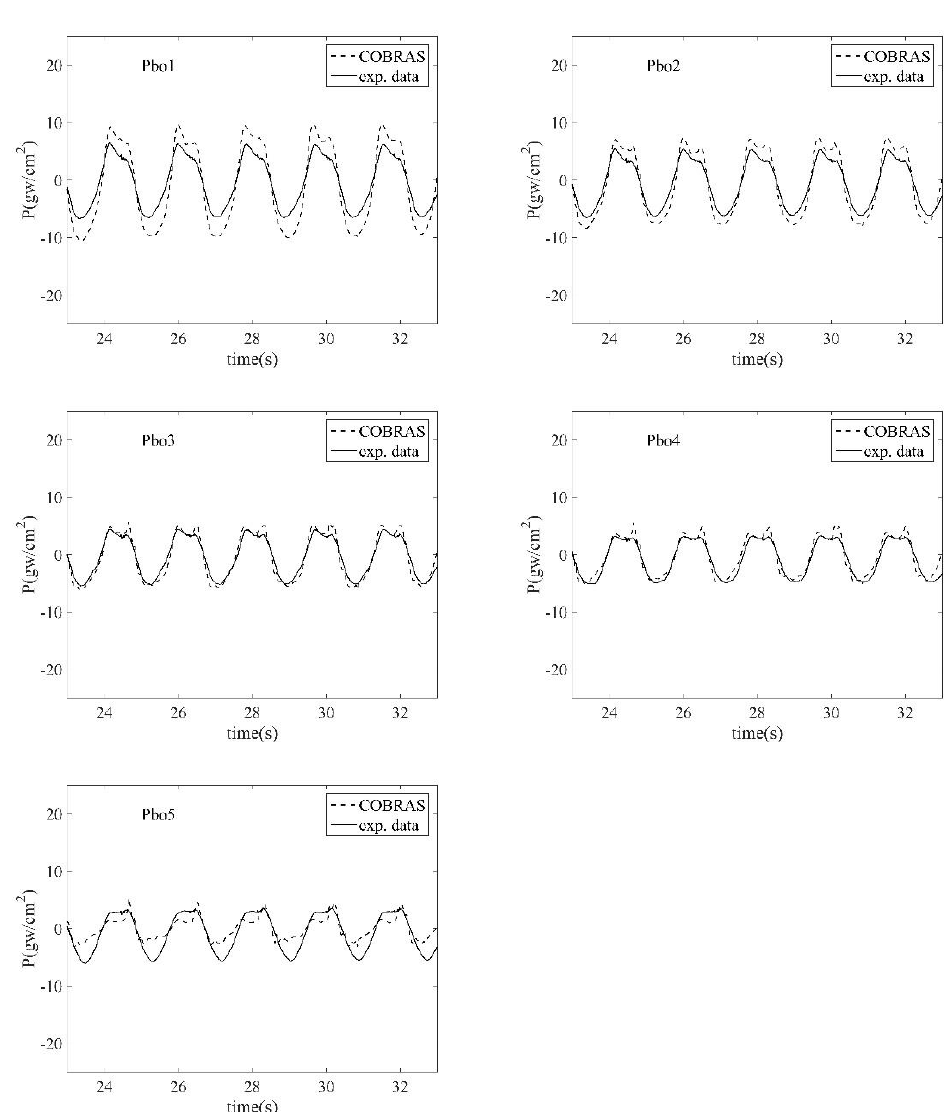
Figure 7. The comparison between numerical model and laboratory measurement for the time series of dynamic wave pressure on the bottom face.